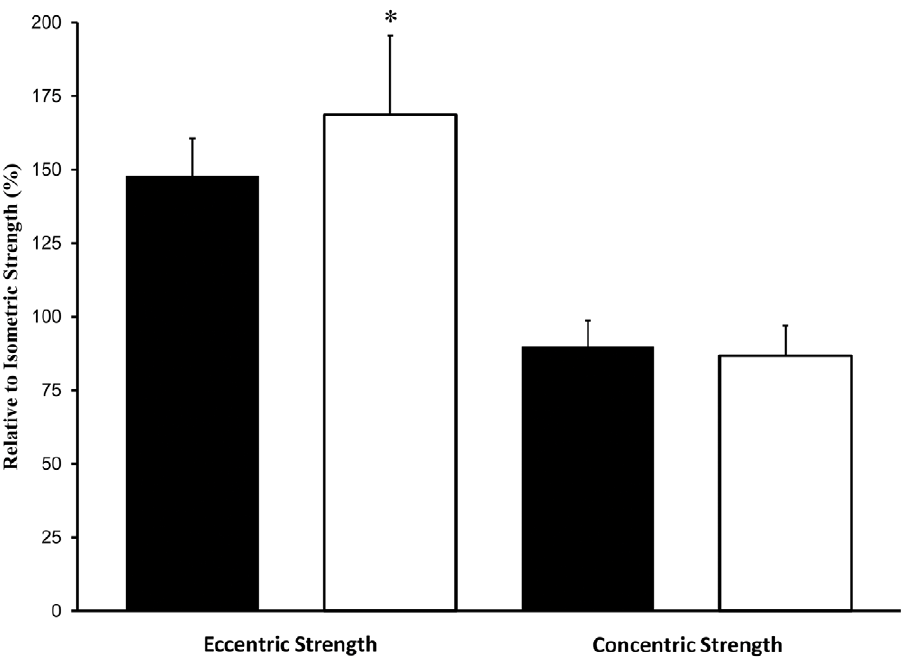
Figure 2. Eccentric and concentric strength in old (open bars) and young men (closed bars) relative to isometric strength. Values are Means 6 standard